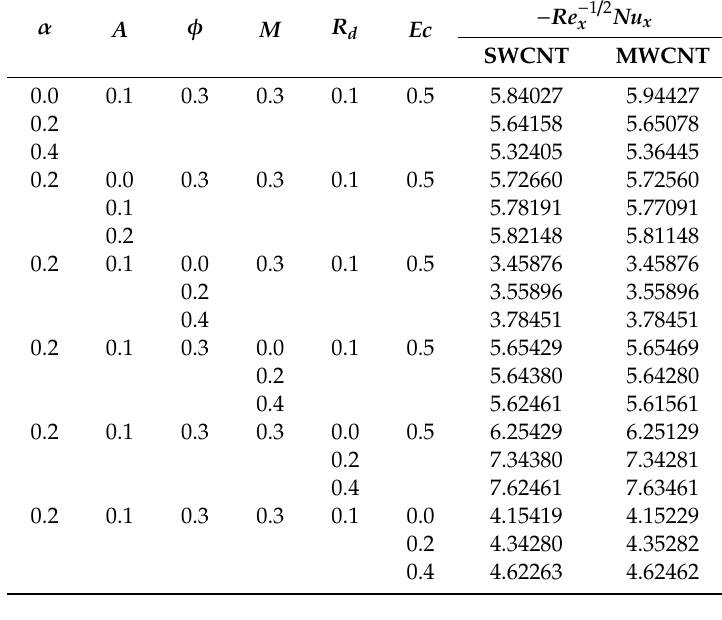
Table 4. Heat transfer (Nusselt number) data.